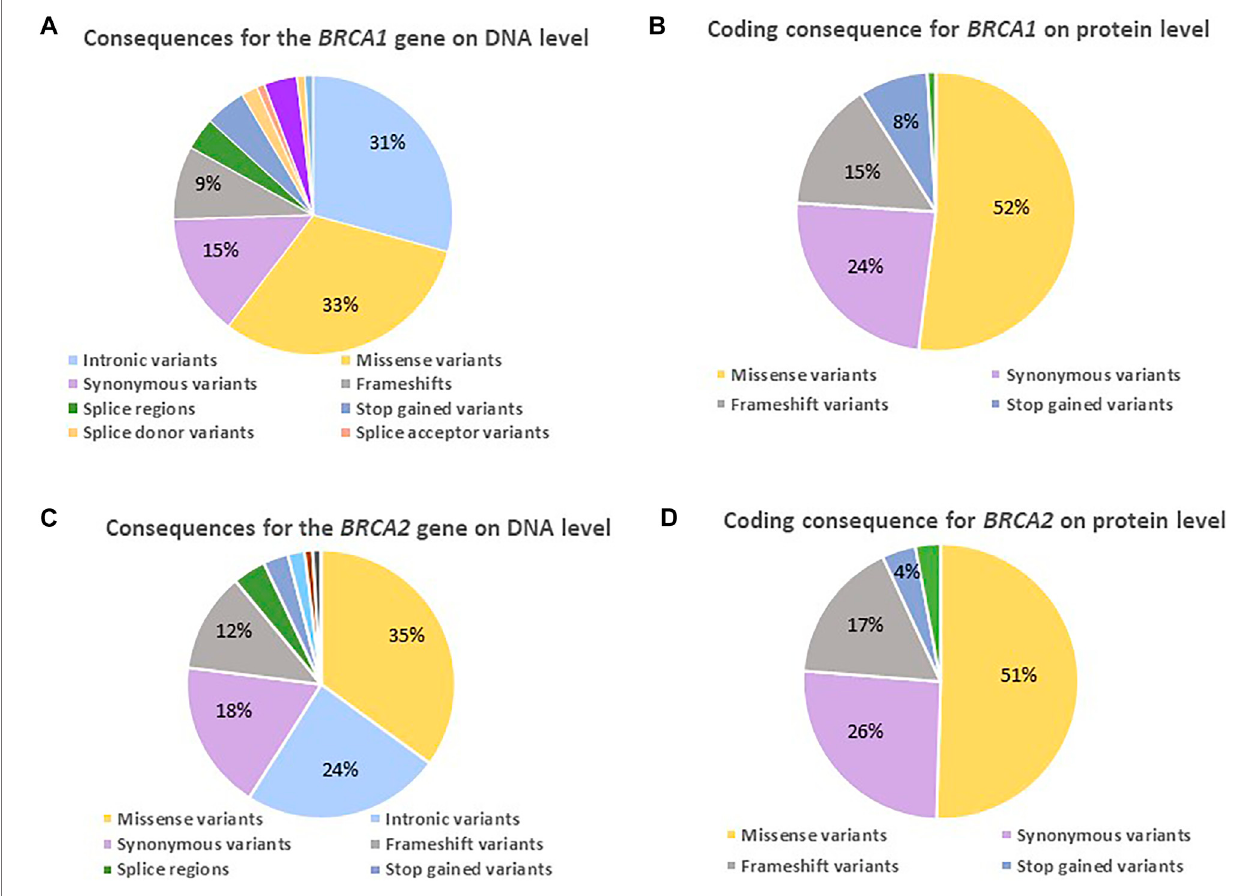
FIGURE 3 | Diagrams indicating the variants detected for the two familial BC genes on DNA and protein level amongst 1,089 BC and/or OVC patients screened using NGS. (A) The consequence ratios (in percentages) predicted for BRCA1 on a DNA level. (B) The consequence ratios predicted for BRCA1 on a protein level. (C) The consequence ratios predicted for BRCA2 on a DNA level. (D) The consequence ratios predicted for BRCA2 on a protein